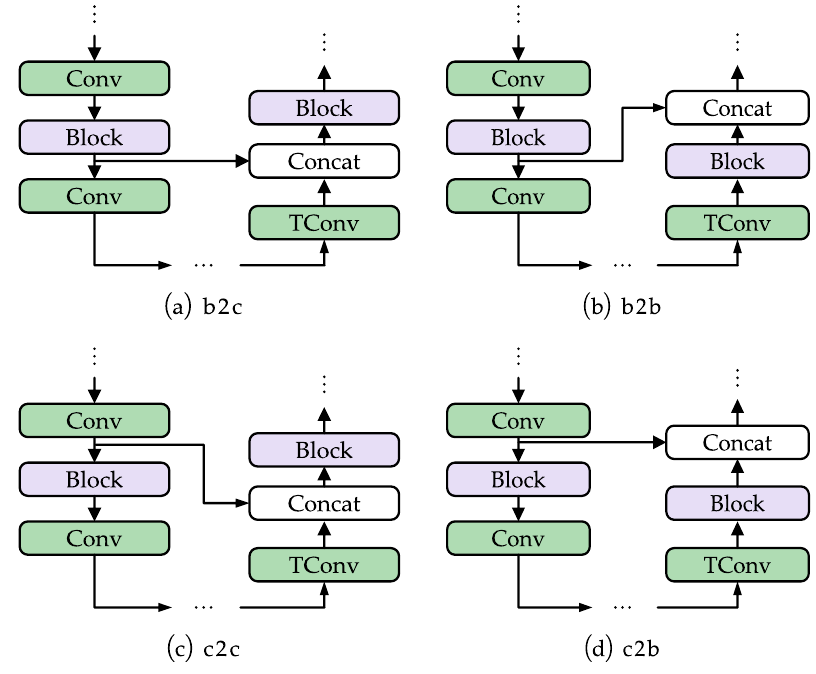
Figure 7. Schematic illustration of different connection mode. Table 5. Results of different connection mode.